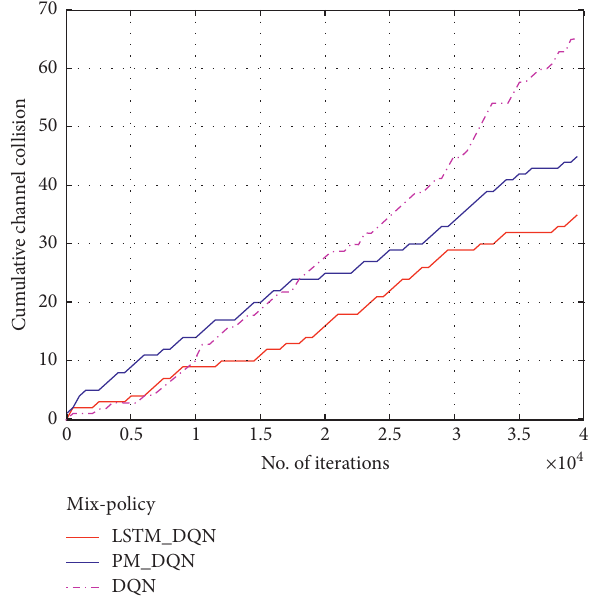
Figure 14: Relationship between the number of iterations and channel collision